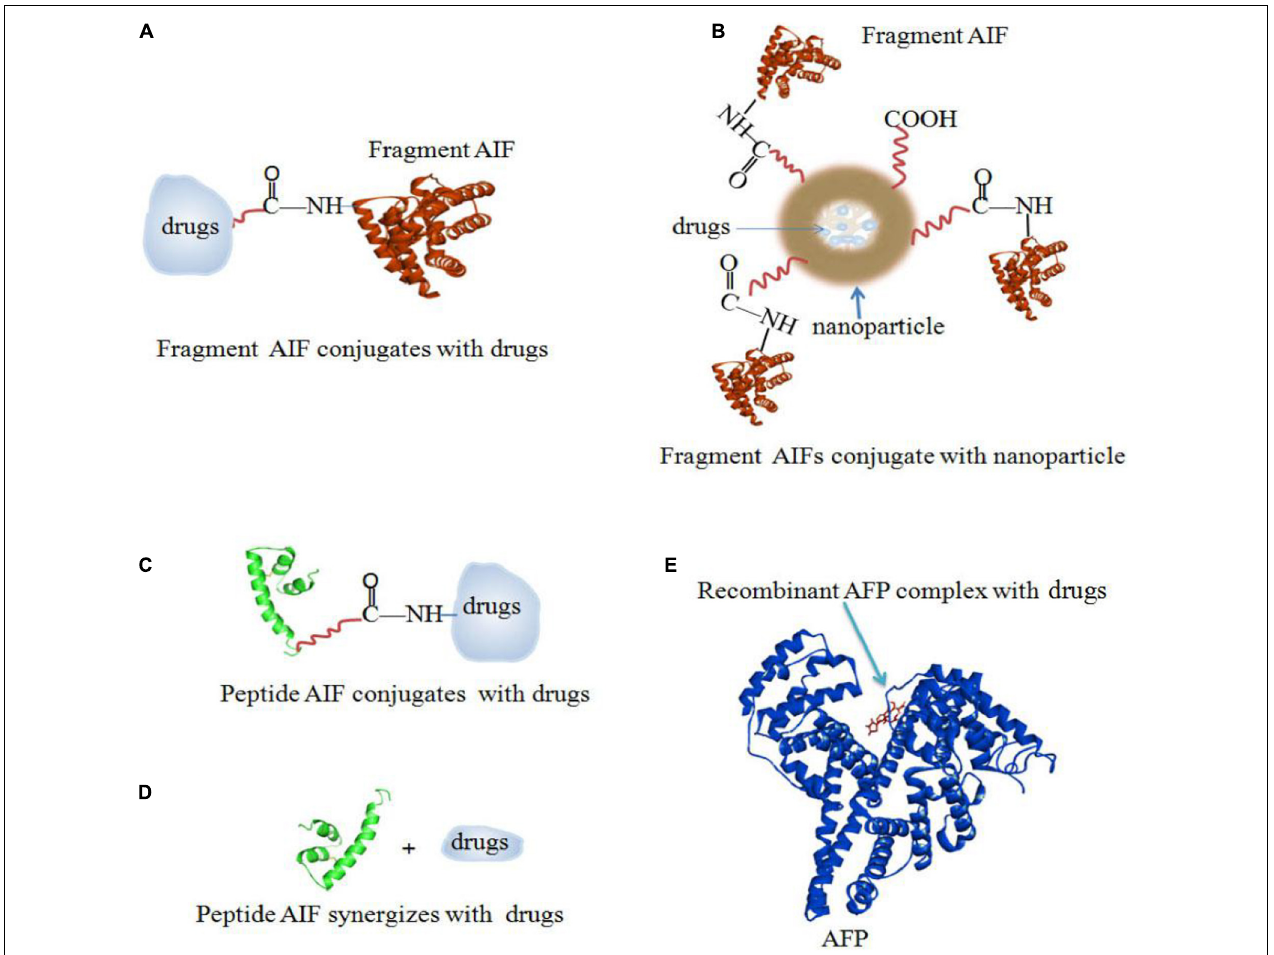
FIGURE 6 | AIFs (fragment AIFs, peptide AIFs and recombinant AFP) conjugate, synergize and complex with drugs. (A) Fragment AIF conjugates with drugs (Posypanova et al., 2013; Yabbarov et al., 2013). (B) Fragment AIFs conjugate nanoparticles with drugs (Godovannyi et al., 2011; Yabbarov et al., 2013). (C) Peptide AIF conjugates with drugs (Mizejewski et al., 2010). (D) Peptide AIF synergizes with drugs (Mizejewski et al., 2010). (E) Recombinant AFP complex with drugs (Arshad et al., 2015; Pak,